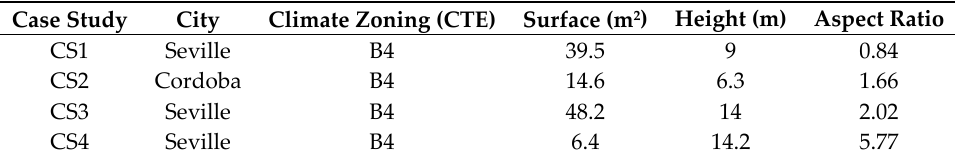
Table 1. General information of set of cases study.